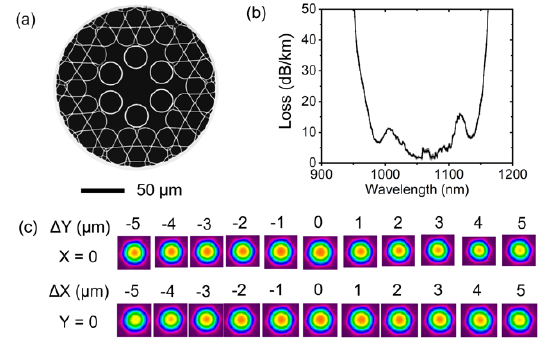
Fig. 2. HKT HCPCF (a) cross-section and (b) loss spectrum. (c) Robustness of the near-field output profile for varying input conditions. Fig. 3. (a) Experimental evolution of the taper diameter